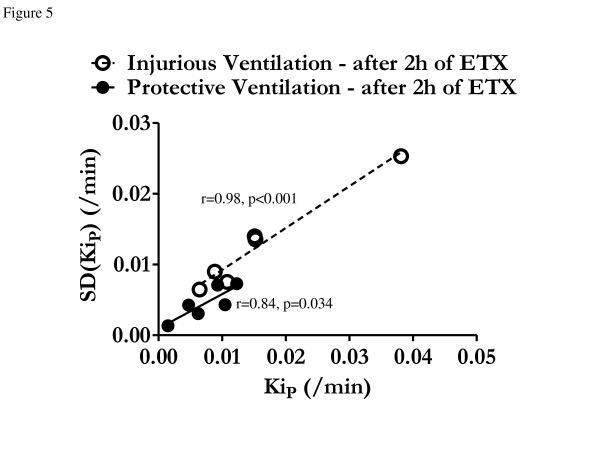
Correlation between mean 18F-fluorodeoxyglucose net uptake rate at the voxel level and 18F-fluorodeoxyglucose uptake using the standard deviation. Linear regression between mean (KiP) and standard deviation (SD(KiP)) of voxel-level 18F-fluorodeoxyglucose (18F-FDG) net uptake rate computed using the Patlak method [31] for protective (filled circles) and injurious (open circles) ventilation groups. There was a significant correlation between mean KiP and SD(KiP) for both the protective ventilation group (continuous line; y = 0.48x + 0.001, r = 0.84, P = 0.034) and the injurious ventilation group (dashed line; y = 0.59x + 0.003, r = 0.98, P < 0.001). Note the offset between the two regression lines showing that, for equivalent KiP values, protective ventilation led to lower SD(KiP) than injurious ventilation.